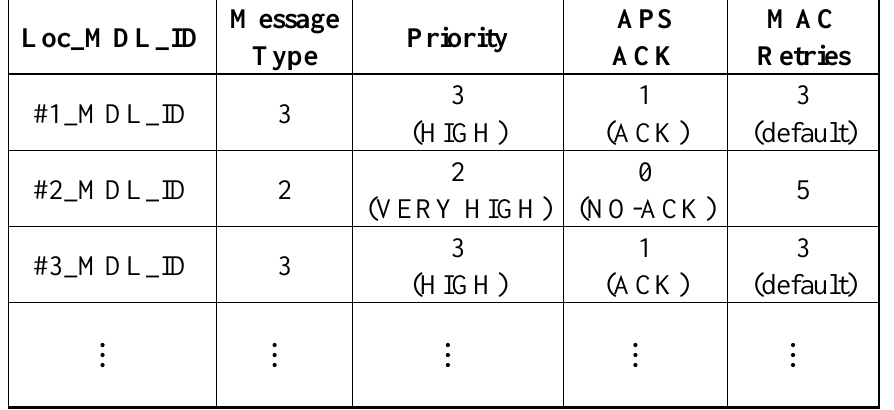
Table 2. BT MDL Connection QoS Parameter Mapping Table for measurement data